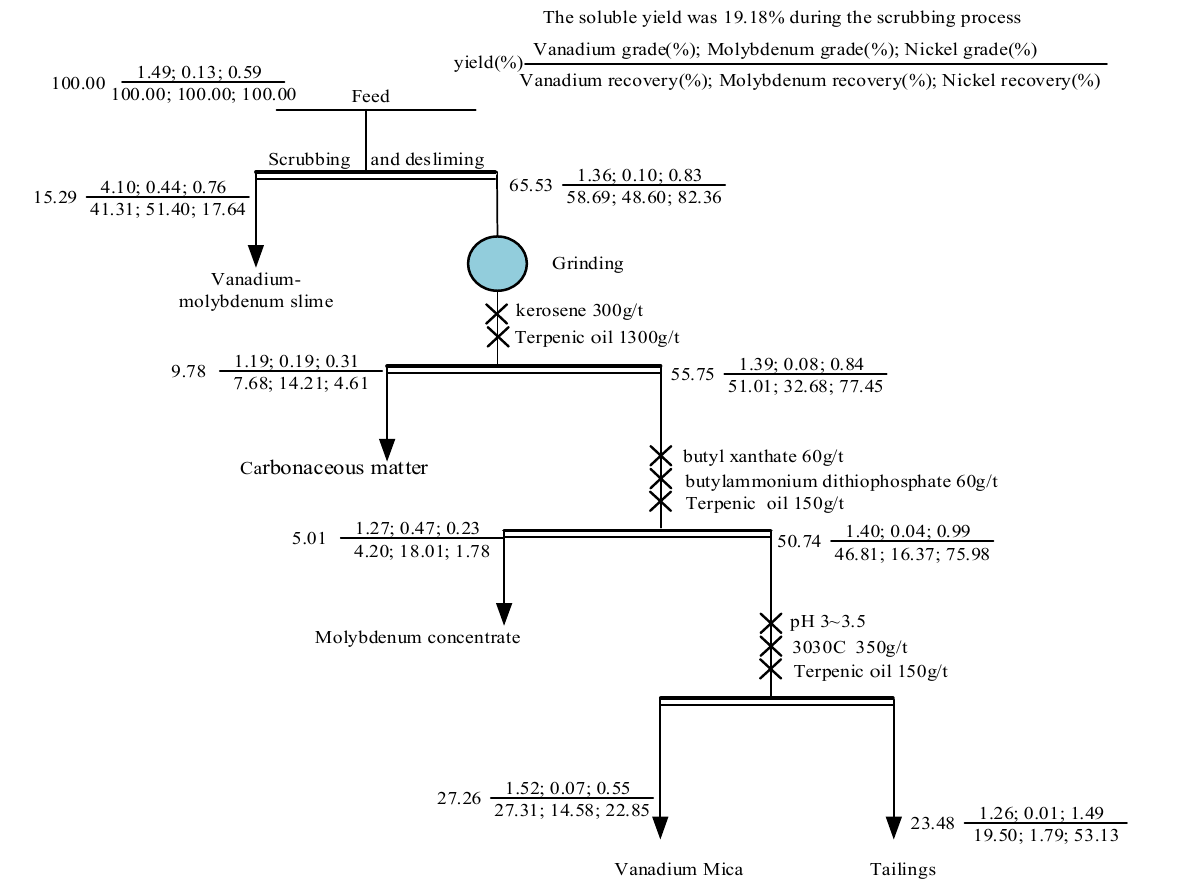
Figure 11. Flow chart of quantity and quality.